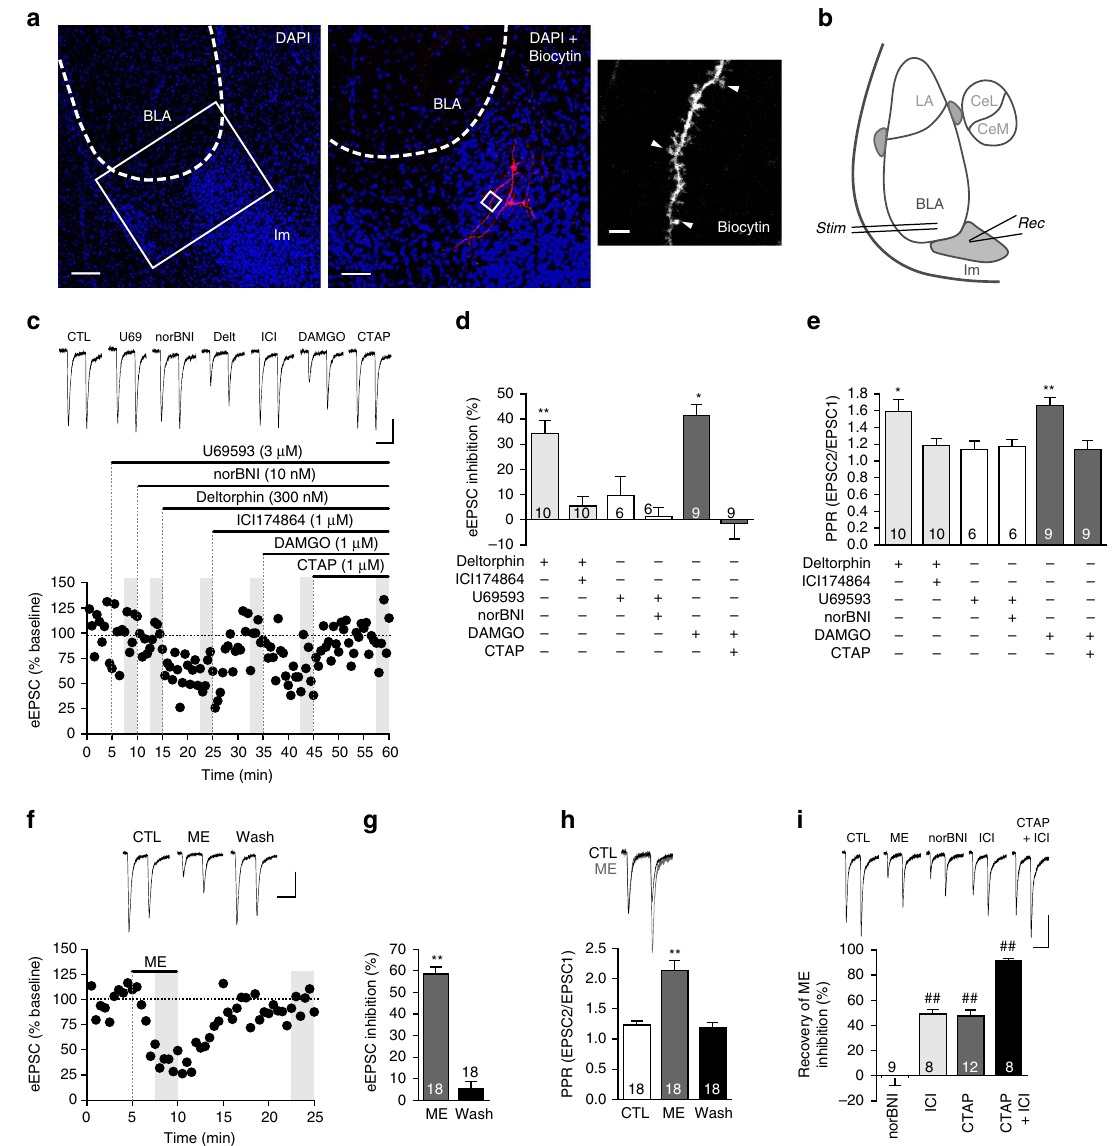
Figure 2 | DOR and MOR activation inhibits glutamate release at the BLA-ITC synapse. ( a ) Post hoc confocal images of DAPI (blue) and biocytin-labelled ITCs (red/white). Low power image shows intense DAPI labelling with high cell density within Im. Single image; scale bar, 100 m m. Magnification ( (cid:3) 20 objective) of boxed area, shows two filled ITCs with bipolar characteristics. Stack image ( z ¼ 13.5 m m); scale bar, 50 m m. Further magnification ( (cid:3) 63, boxed area) reveals dendritic spines (arrows); single Z section ( z ¼ 2.5 m m); scale bar, 3 m m. ( b ) Representative BLA-Im stim ulation and rec ording locations. ( c – e ) Selective DOR (deltorphin II, Delt 300nM) and MOR (DAMGO, 1 m M)) agonists, reduced eEPSC amplitude and increased PPR that was reversed by the corresponding antagonists ICI1173864 (ICI, 1 m M) and CTAP (1 m M), respectively. KOR agonist (U69, 3 m M) and antagonist norBNI (10nM), had no effect. ( c ) Example eEPSCs and time plot of normalized peak amplitude (eEPSC 1 ) of a single representative experiment. ( d ) Bar chart showing percentage inhibition from baseline. Baseline defined as eEPSC amplitude of CTL (no drug) or previous antagonist. ( e ) Bar chart showing PPR, calculated as eEPSC 2 /eEPSC 1 . ( f – h ) ME (10 m M) reduced eEPSC amplitude and increased PPR which fully reversed after wash. ( f ) Example eEPSCs and time plot of single representative experiment; ( g ) bar chart of mean inhibition during ME and wash. ( h ) Bar chart of mean PPR (bottom) and example traces (top) normalized to first eEPSC before (black) and during ME (grey). ( i ) ME inhibition was fully reversed by combined DOR and MOR antagonist treatment. Example eEPSCs and bar chart showing the proportion of ME inhibition of eEPSC amplitude (%) reversed by the selective antagonists. (Data are represented as mean ± s.e.m.; * P o 0.05, ** P o 0.01, paired t -test, from CTL; ## P o 0.01, paired t -test versus ME.) Highlighted regions on time plots represent region sampled for bar charts. Scale bars, 50ms,